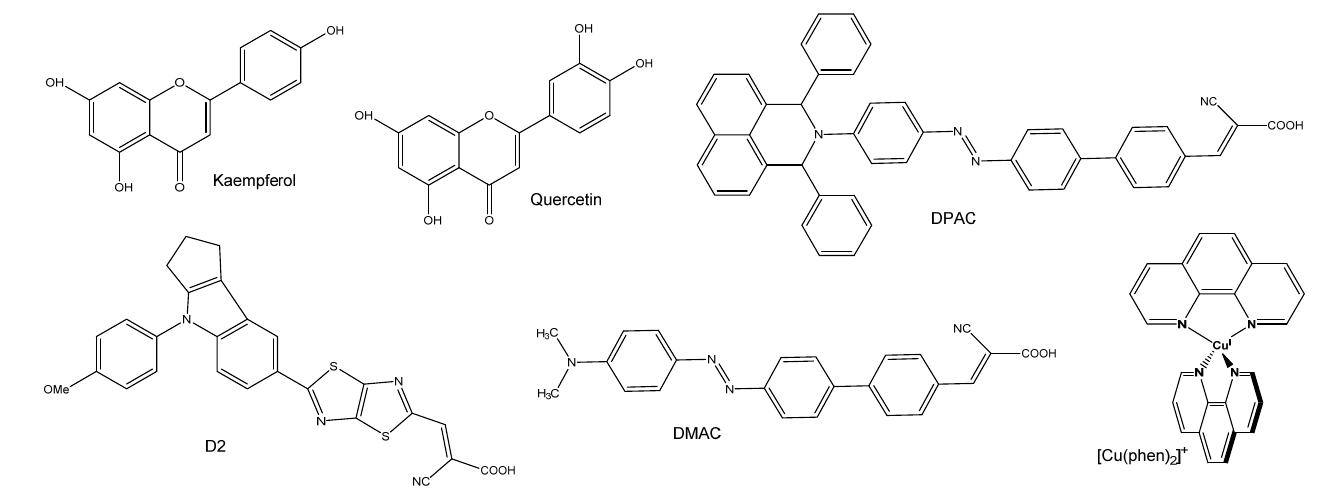
Figure 8. Structures of dyes theoretically investigated as photochromic dyes for